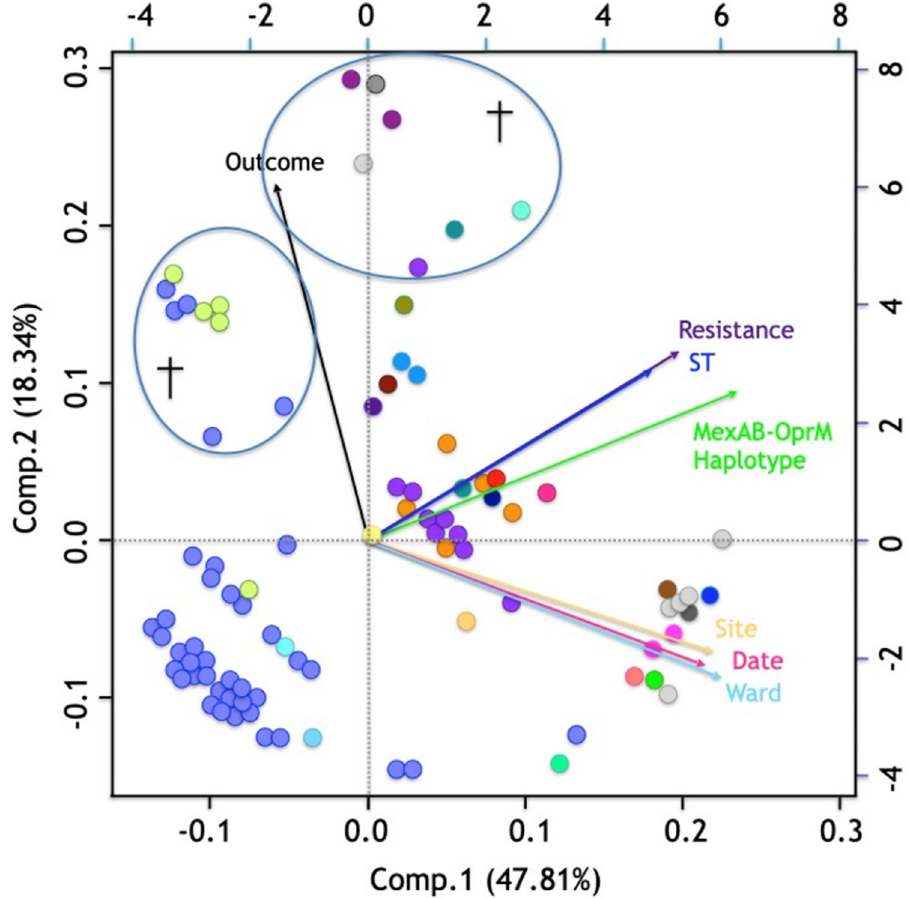
Fig 4. Principal component analysis of the 91 P . aeruginosa strains. P . aeruginosa isolates (n = 91). Each strain is represented by a colored dot according to mexR-nalC-nalD haplotype (Fig 1). †: Fatal patient outcome. Variables included: Outcome (black vector): living, died; Resistance (purple vector): sensitive (S), multi-drug resistant (MDR), extensively drug resistant (XDR), and pan drug resistant (PDR); ST (blue vector) (n = 48); MexAB-OprM haplotype ( mexR-nalC-nalD ) (green vector) (n = 27); Isolation site (yellow vector): hospital, environmental; Date (pink vector): 2007–2013; Hospital ward (aqua vector): Stx, surgical therapy; E, emergency room; N, neurology; PICU, pediatric intensive care unit; P, pediatrics; S, surgery; Neph, nephrology; O, oncology; It, internal therapy; C, cardiology; NICU, neonatal intensive care unit; Ne, necropsy; IMed, internal